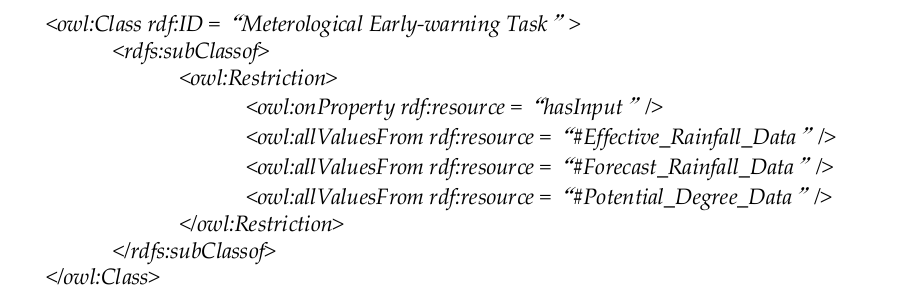
Figure 9. Snippets of owl notation using a universal restriction.